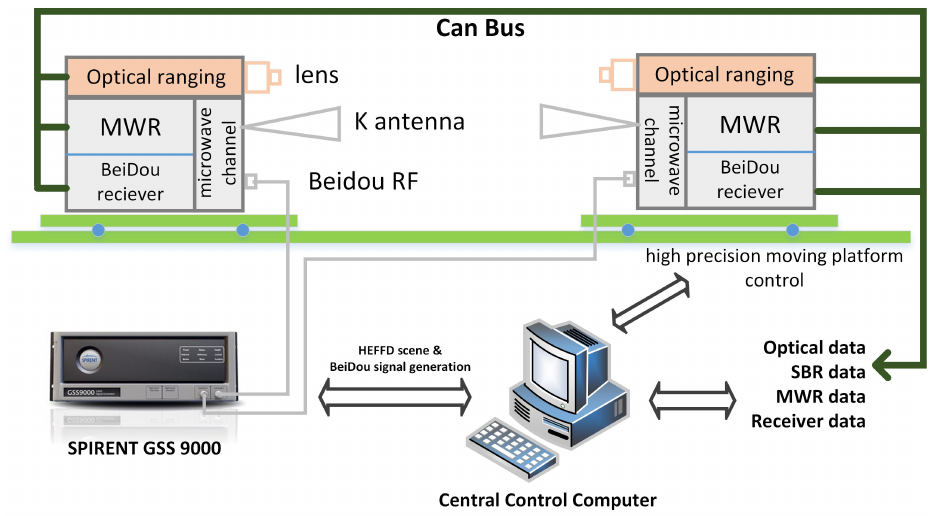
Figure 11. Block diagram of the simulation platform, including a high-precision 6-DOF moving platform, optical/MWR/BeiDou payloads, a SPIRENT GSS9000 simulator, central control computer, and standard CAN bus